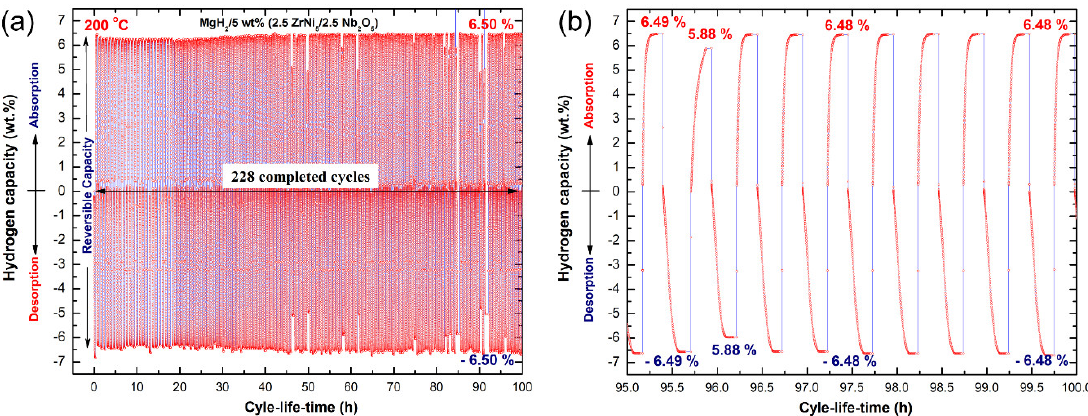
Figure 10. Cycle-life-time of nanocomposite MgH 2 /5 wt% (2.5 ZrNi 5 /2.5 Nb 2 O 5 ) powders conducted at 200 °C under hydrogenation and dehydrogenation pressure of 10 bar and 200 mbar, respectively. The figure shows ( a ) completed 228 cycles conducted within 100 h and ( b ) the last 9.5 cycles (95 h to 100 h).